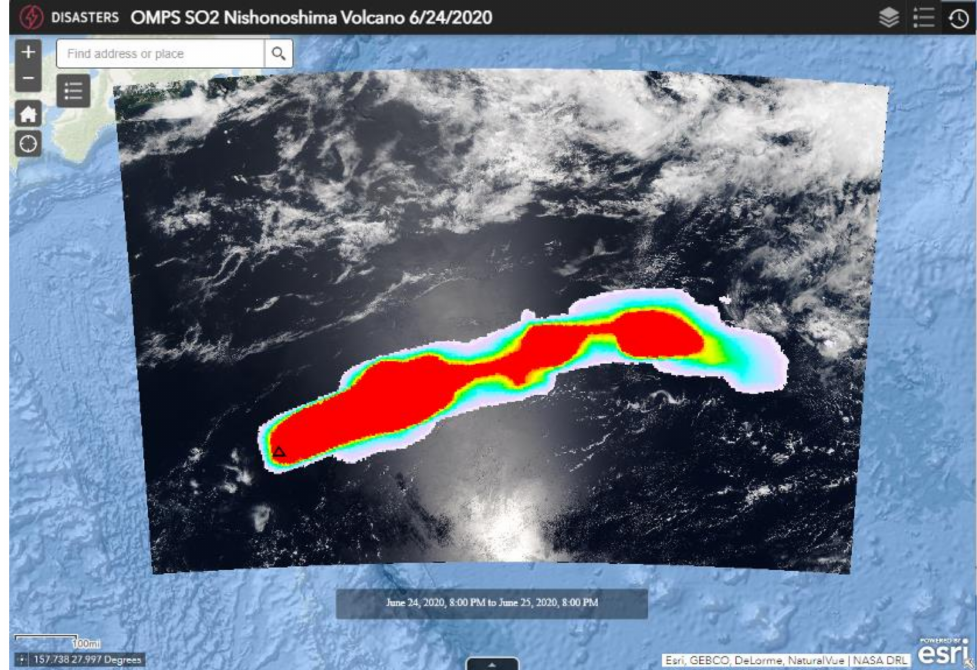
Figure 7. Time-enabled web application hosted in the Disasters Mapping Portal (https://go.nasa. gov/3v4MSft accessed on 5 October 2021) showing OMPS SO 2 column density overlayed on VIIRS True Color Imagery on 25 June 2020, for the Nishinoshima volcano (triangle)